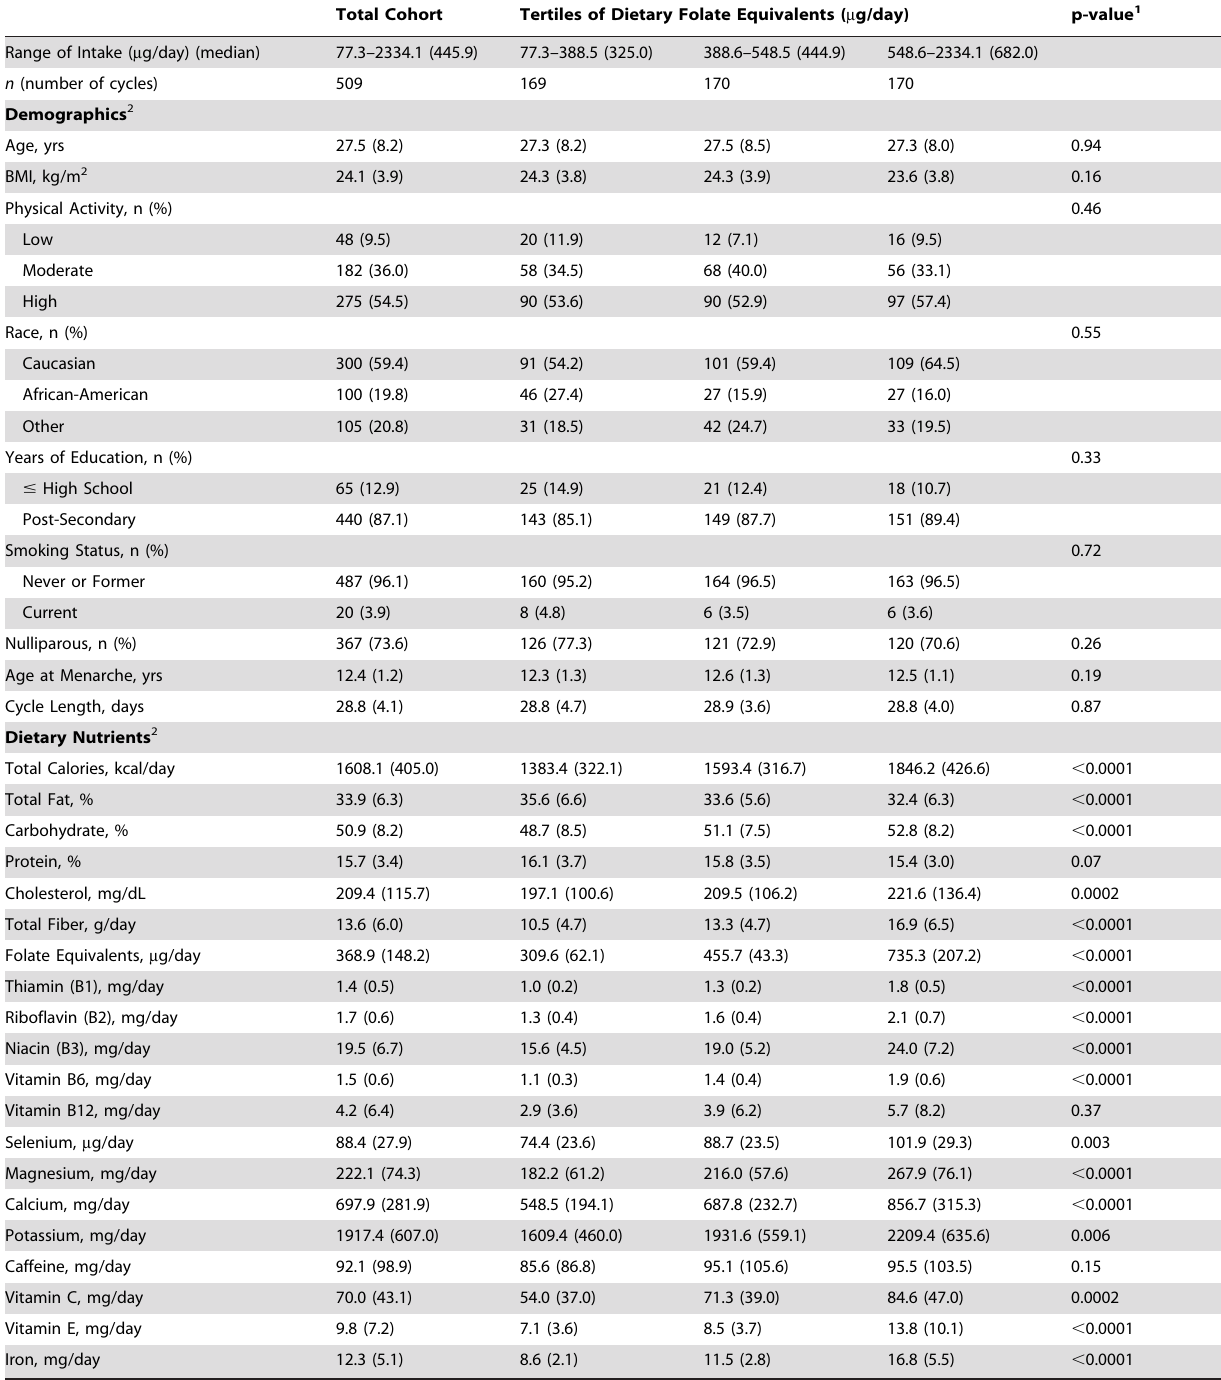
Total Cohort Tertiles of Dietary Folate Equivalents ( m g/day) p-value